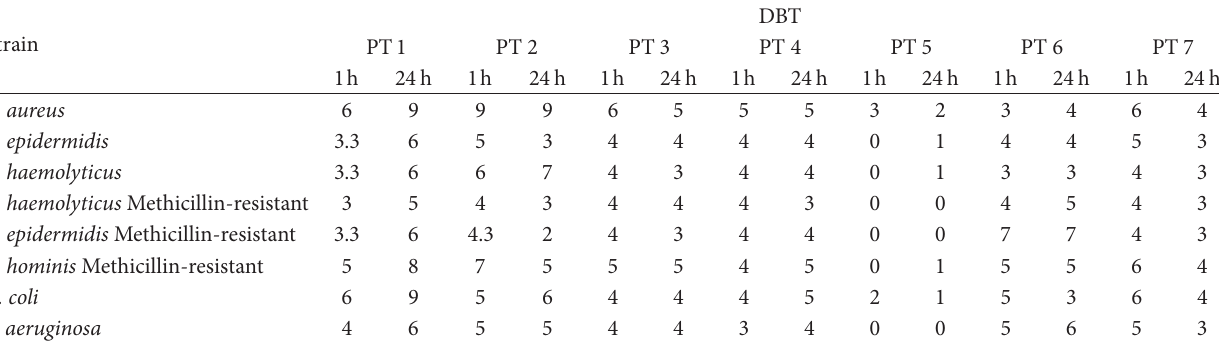
Table 2: Bactericidal titer of drainage fluids collected from 7 patients within the first 24 hours of spacer implantation against multiresistant clinical